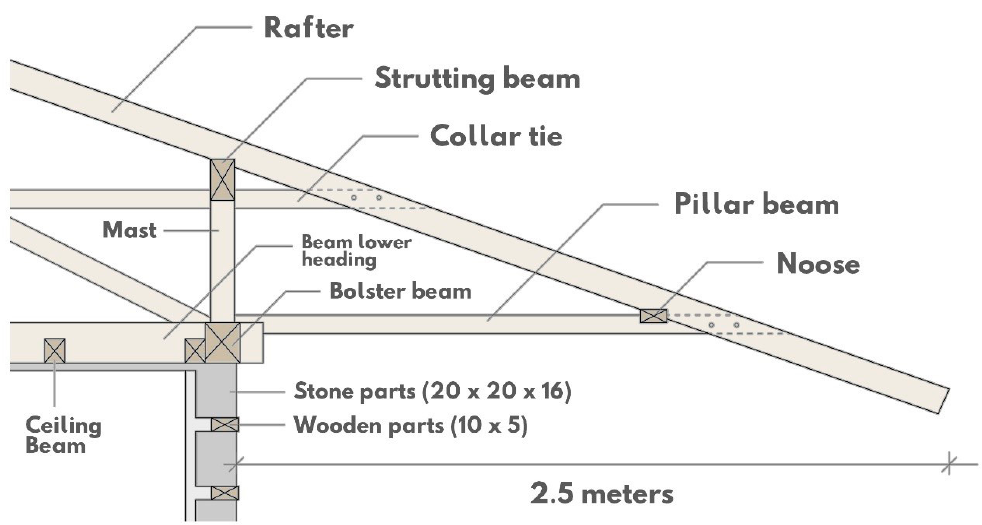
Figure 4. The detail of the ‘Kara Saçak’ (re-illustrated from Ş en (1967)).